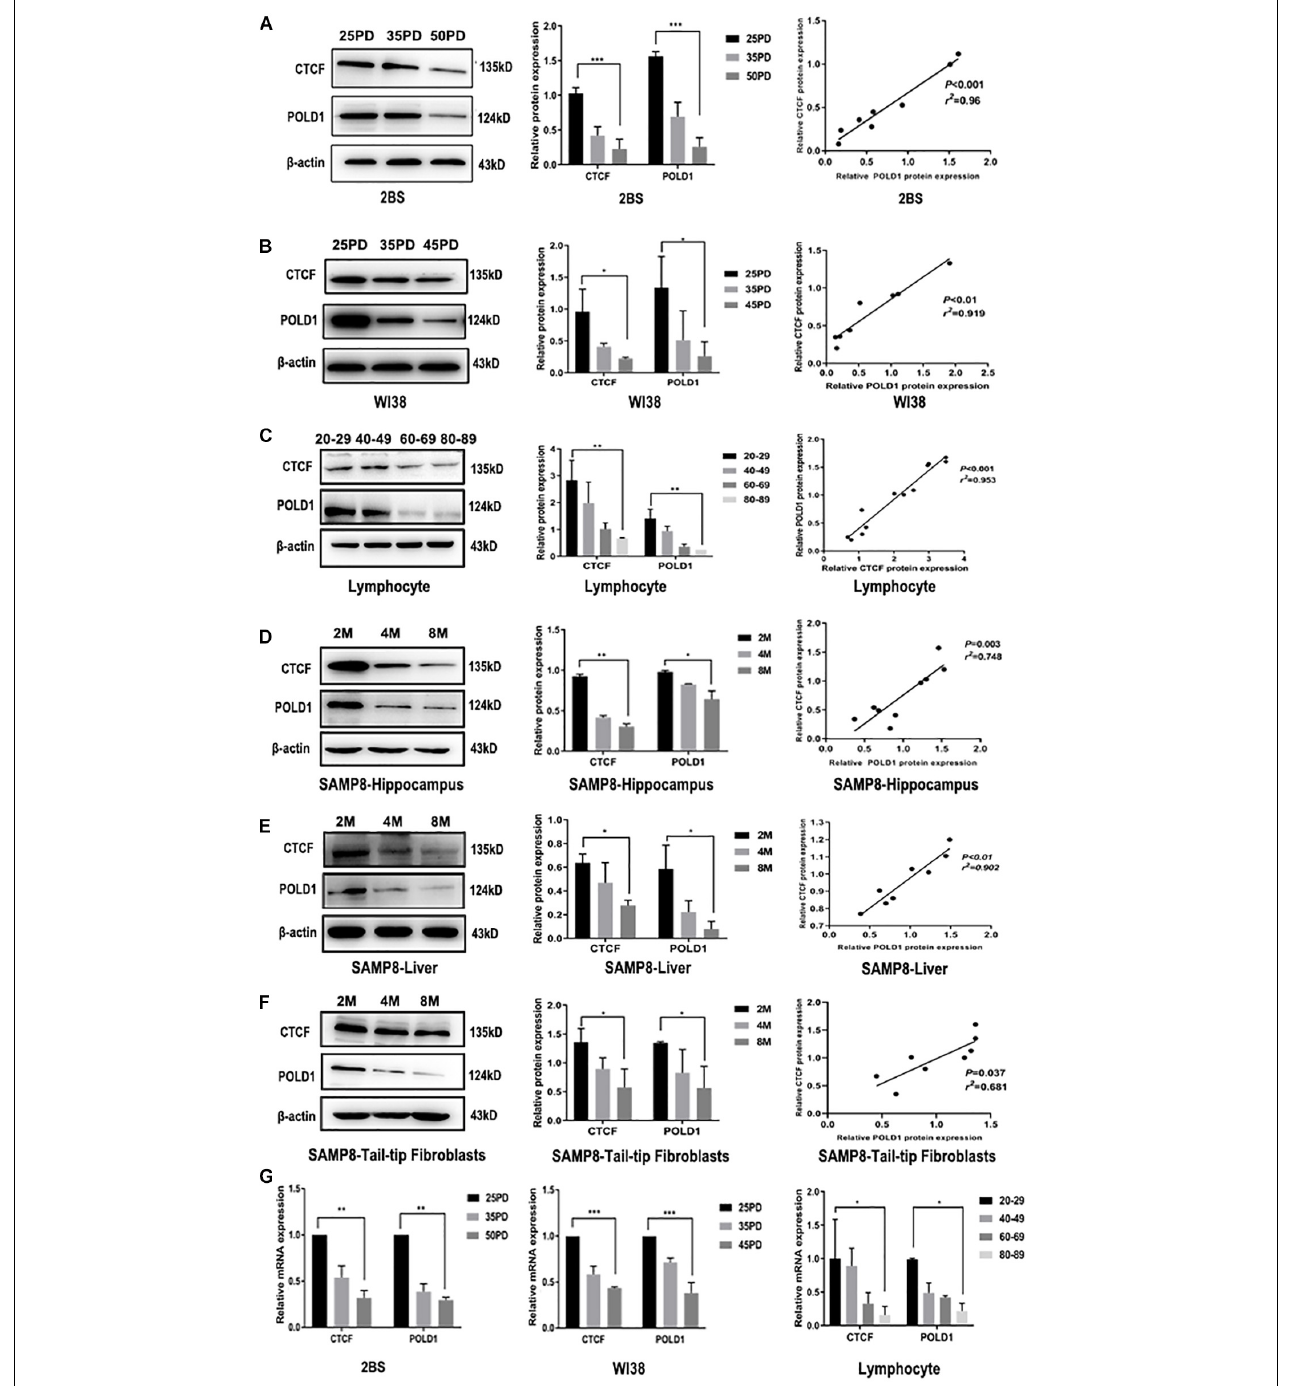
FIGURE 2 | Both CCCTC-binding factor (CTCF) and DNA polymerase delta 1, catalytic subunit (POLD1) expression levels were reduced with aging. (A) Protein expression levels and relationship of CTCF and POLD1 in different population doublings (PDs) of 2BS cells ( n = 3). (B) Protein expression levels and relationship of CTCF and POLD1 in different PDs of WI38 cells ( n = 3). (C) Protein expression levels of CTCF and POLD1 in the lymphocytes of healthy people of different ages ( n = 20 in every group). (D) Protein expression levels of CTCF and POLD1 in the hippocampus of SAMP8 mice at different ages in months ( n = 18). (E) Protein expression levels of CTCF and POLD1 in livers of SAMP8 mice at different ages in months ( n = 18). (F) Protein expression levels of CTCF and POLD1 in the 3PD mouse tail-tip fibroblasts of SAMP8 mice at different age in months ( n = 18). (G) mRNA expression levels of CTCF and POLD1 in different PDs of 2BS, WI38 cells, and lymphocytes of healthy people of different ages. β -actin was used for the normalization of data. Data were analyzed using one-way ANOVA, and data are shown as mean ± SEM, with three independent experiments in each group. * P < 0.05, ** P < 0.01, *** P < 0.005. The correlation was determined using Pearson’s correlation